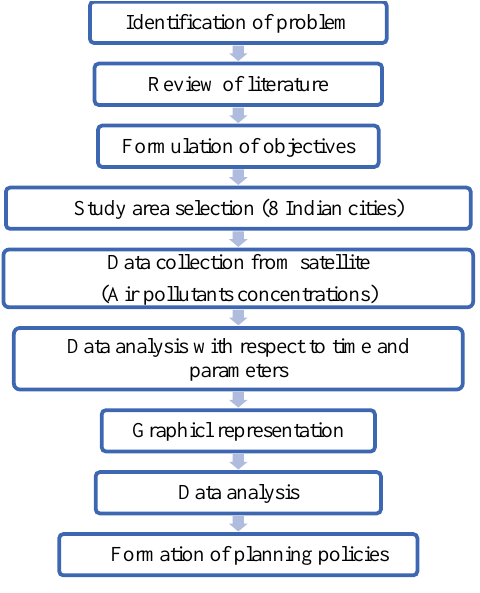
Figure 2. Methodology flow chart